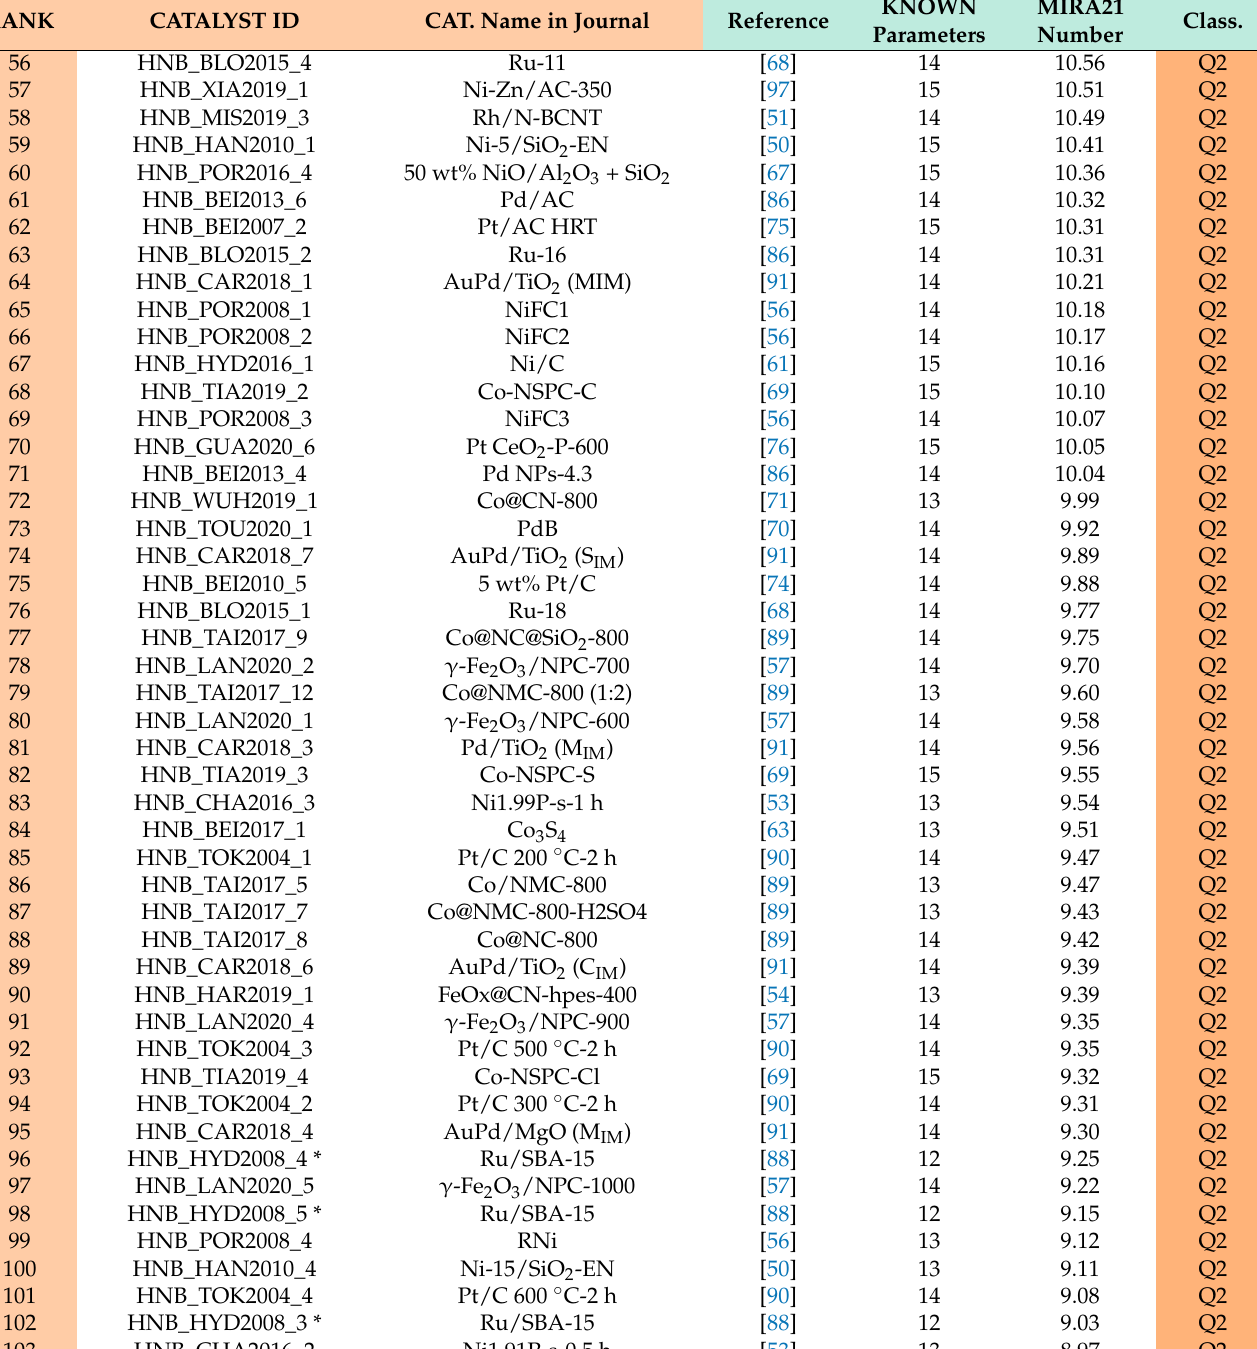
Table 5. List of Q2 catalysts according to